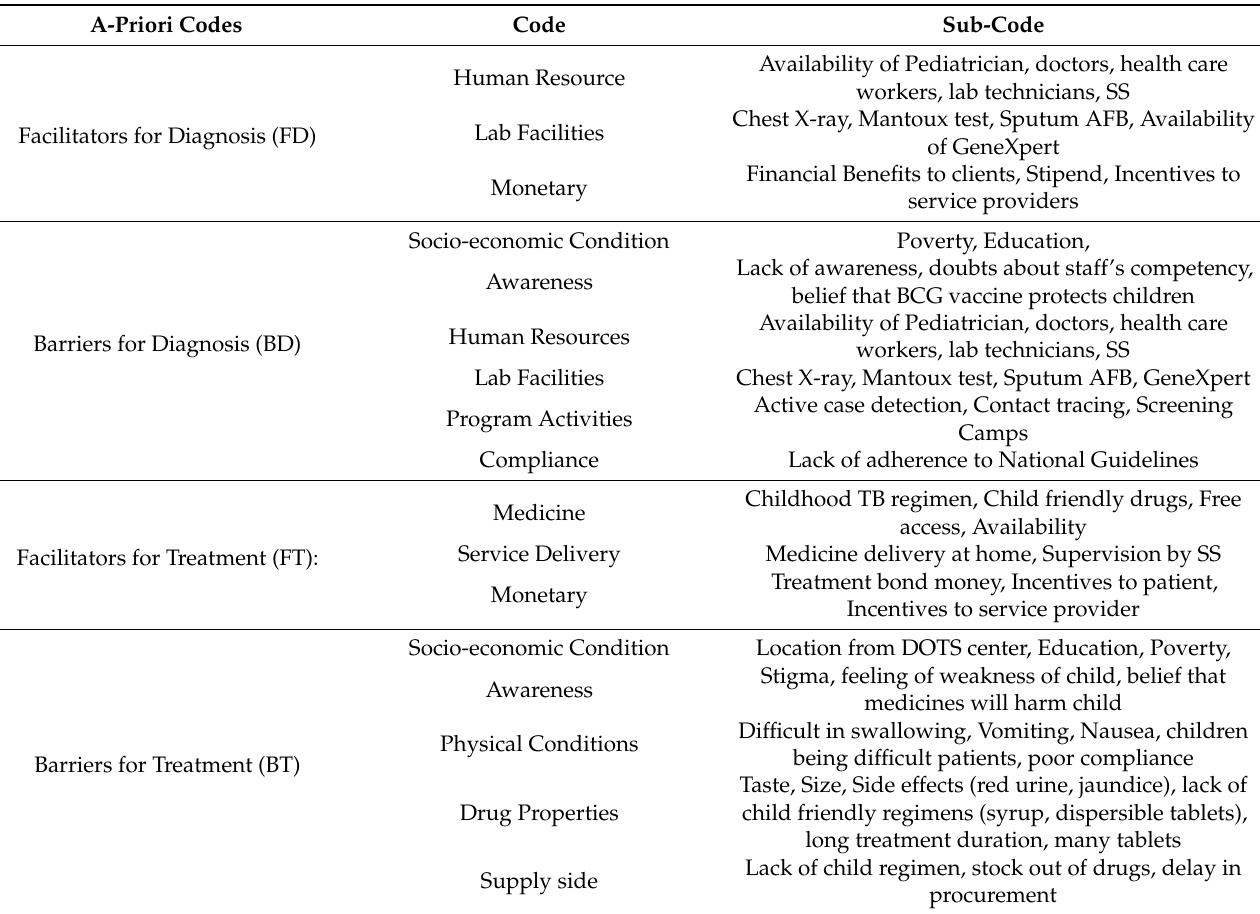
Table 2. A-priori codes for data